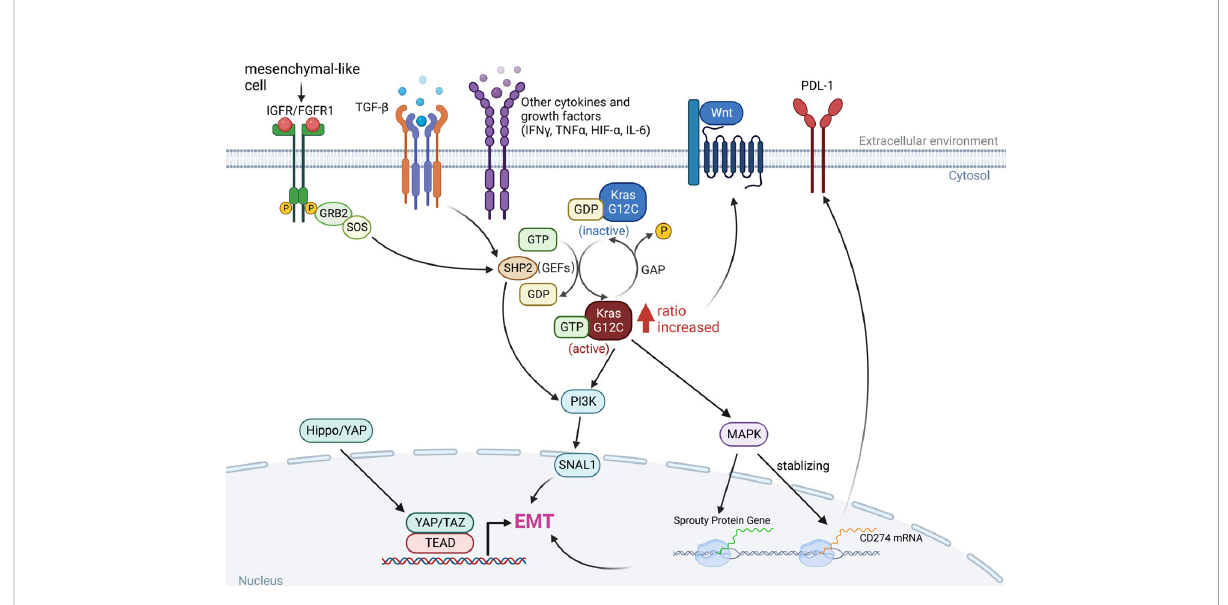
FIGURE 3 The interaction between KRAS signaling and EMT. The KRAS-MAPK pathway is important for the stability of CD274 (PD-L1) mRNAs. KRAS signaling and YAP/TAZ converge to activate transcriptional programs that regulates EMT and EMT is a key driver of tumor immune evasion. IGFR, insulin-like growth factor receptor; FGFR1, fi broblast growth factor receptor 1; TGF- b , transforming growth factor-beta; IFN- g , interferon gamma; TNF- a , tumor necrosis factor-alpha; HIF- a , hypoxia-inducible factor-alpha; IL-6, interleukins 6; SNAI1, snail family transcriptional repressor